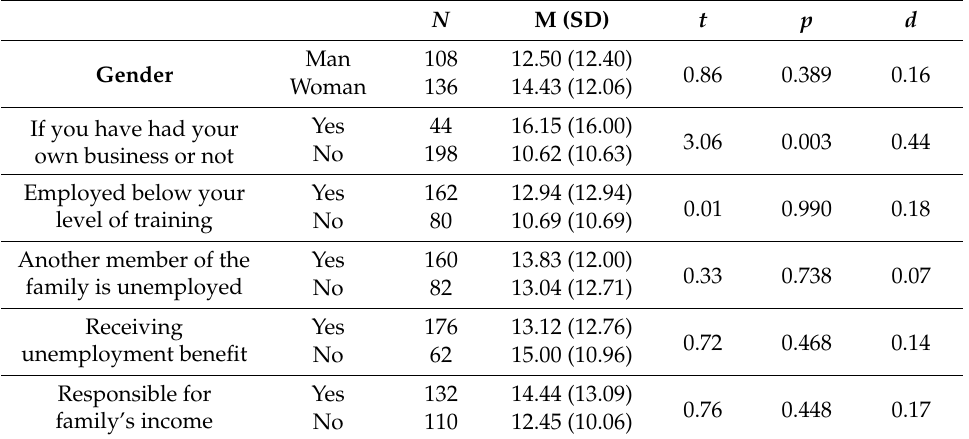
Table 1. Means, standard deviation, independent samples T -test and effect size of Beck’s Anxiety Inventory